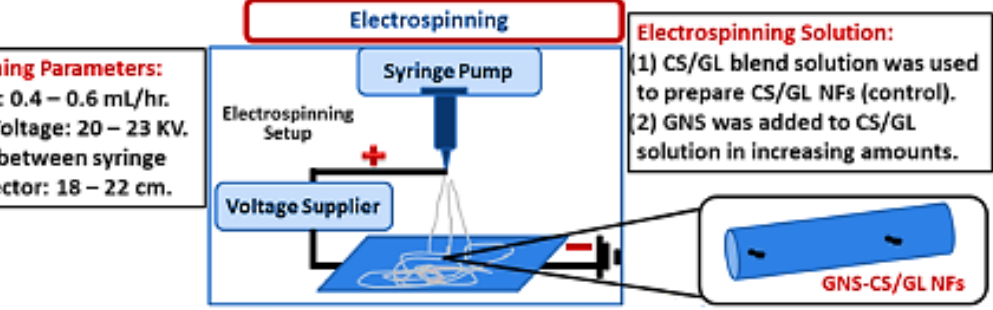
Figure 3. Schematic of electrospun nanofiber formation [90]. GS/GL NF — chitosan/gelatin nano fiber; GNS — graphene nanosheet. Reproduced with permission from Reference [90]. Copyright 2022 American Chemical Society.